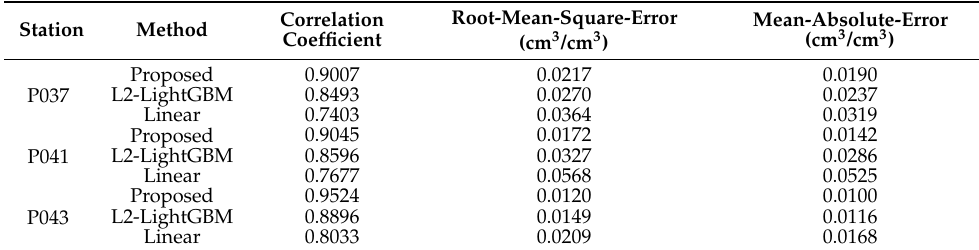
Table 3. Soil moisture retrieval precision statistics.